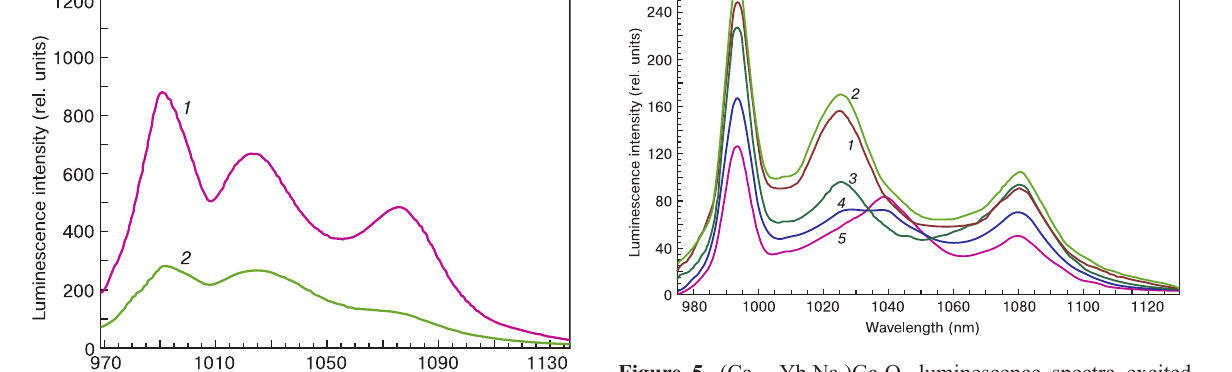
Figure 5. (Ca with 940 nm radiation for different activator ion concentrations: Yb )Ga O ( 1 ) х = y = 0.5 mol.%; ( 2 ) 1 mol.%; ( 3 ) 5 mol.%; ( 4 ) 10 mol.%; 0.95 0.05 2 4 (5) 15